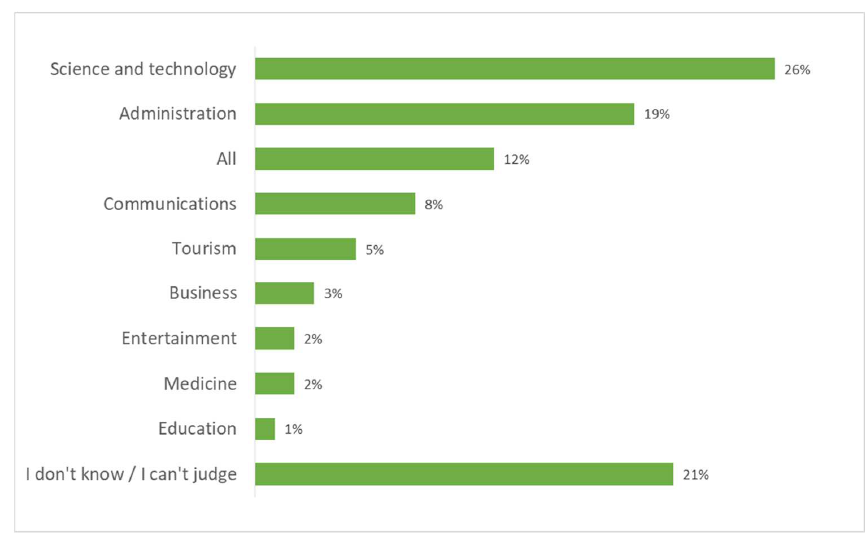
Figure 12. In which areas will AI translations find the most applications? N = 99.